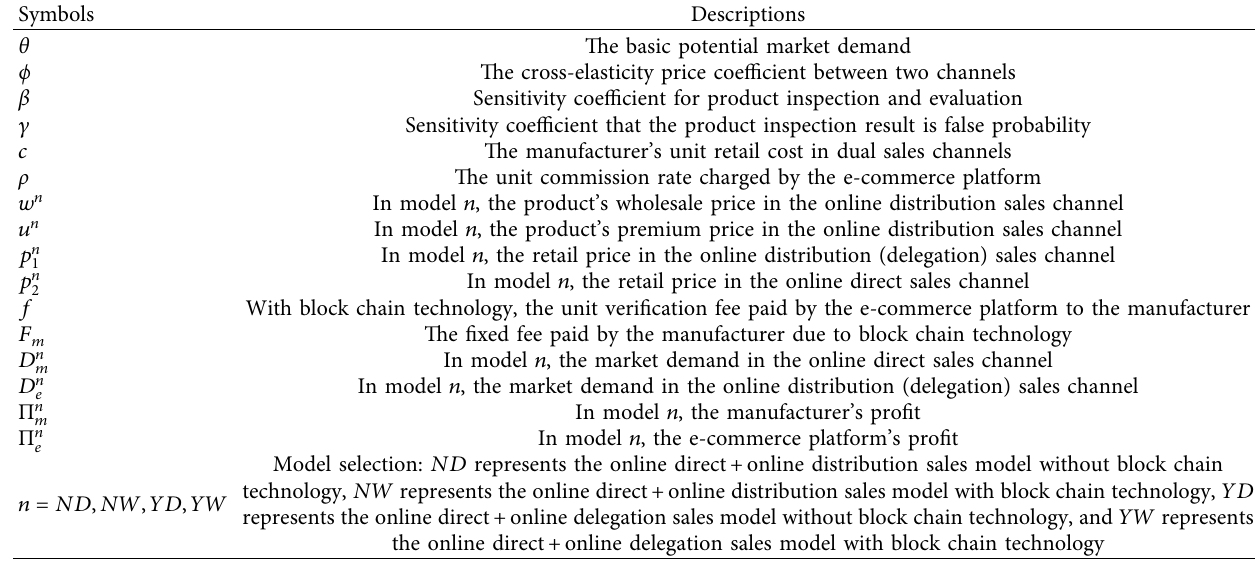
Table 1: Description of main parameters and variables.